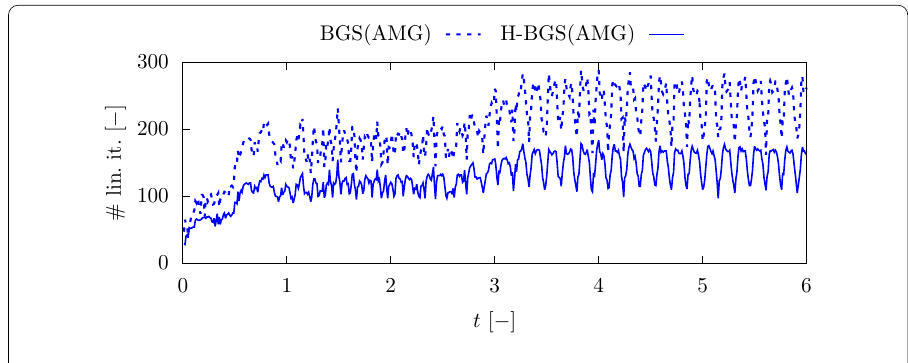
Fig. 11 Comparison of preconditioners in the presence of large mesh deformation—also for large deformations and distortions of the fluid/ALE mesh, the H-BGS(AMG) preconditioner reduces the number of GMRES iterations per time step compared to the BGS(AMG)